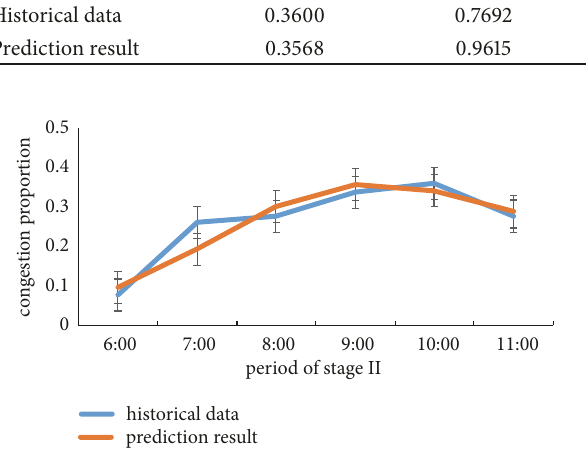
Figure 13: Prediction result on stage IV in different days. Table 3: Comparison between complex model and simplified